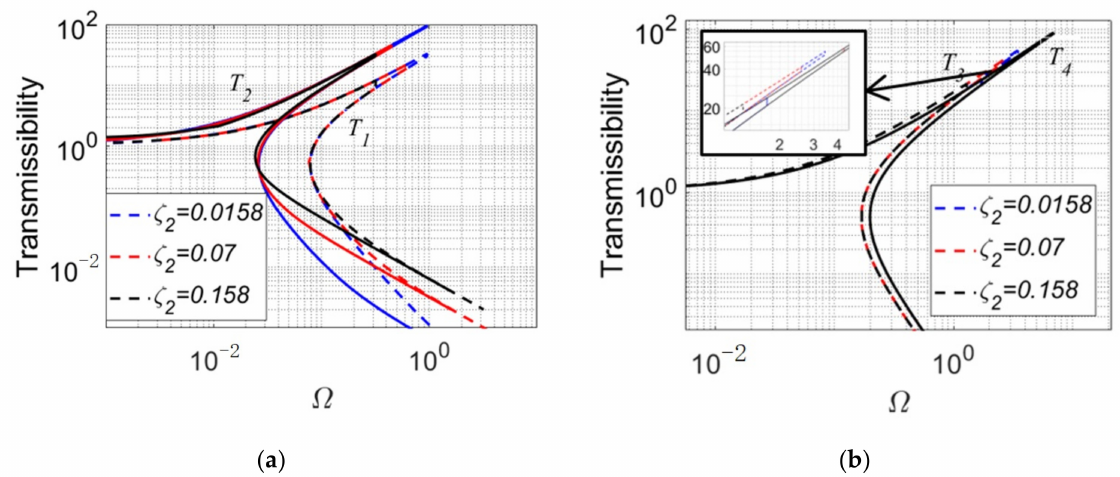
Figure 19. Comparison of displacement transmissibility in variation with damping: ( a ) displacement; ( b ) rotation. Dash lines show the vertical results, solid lines show the horizontal